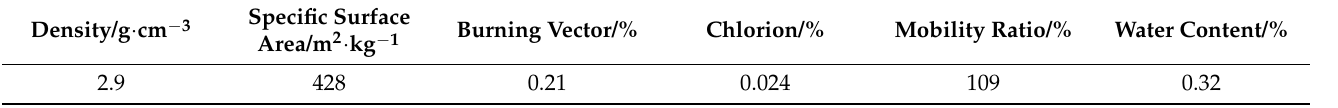
Table 4. Physical property index of blast furnace